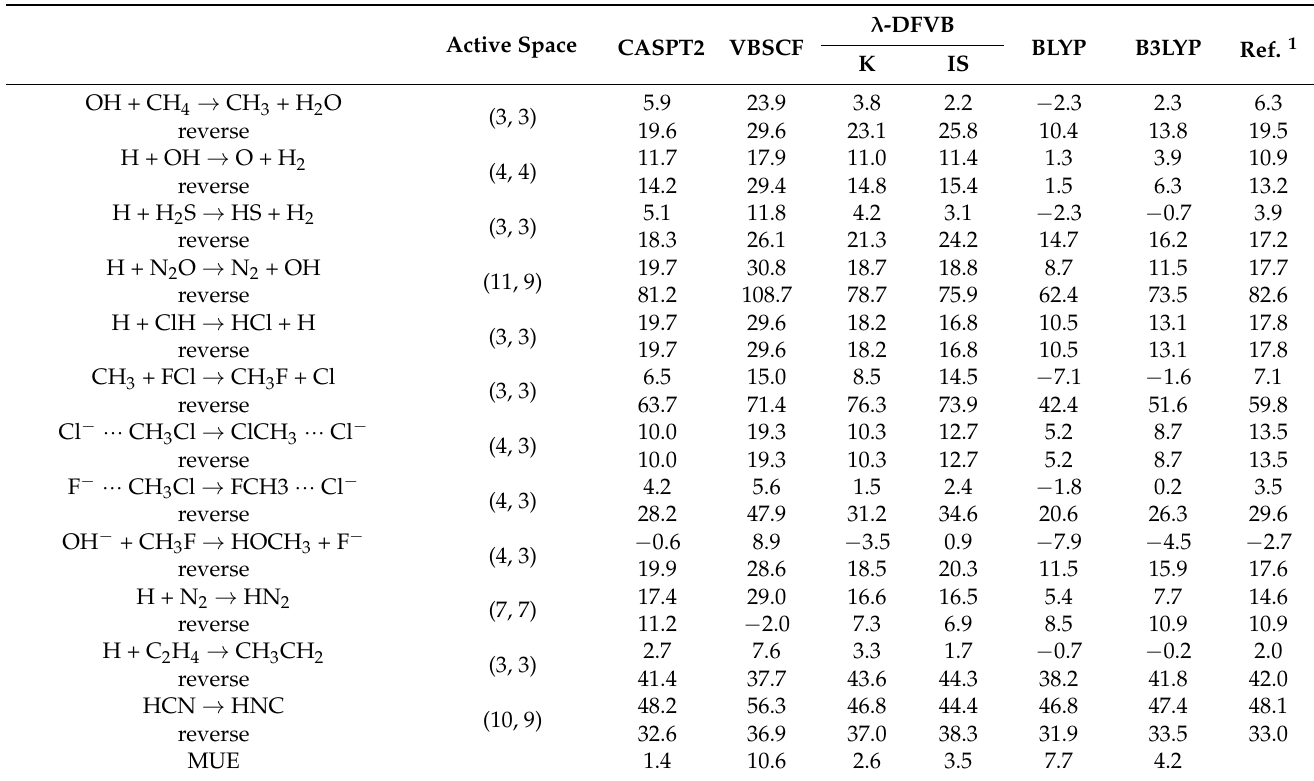
Table 5. Forward and reverse barrier heights (in kcal/mol) of the twelve reactions in the DBH24 dataset. λ Active Space CASPT2 VBSCF